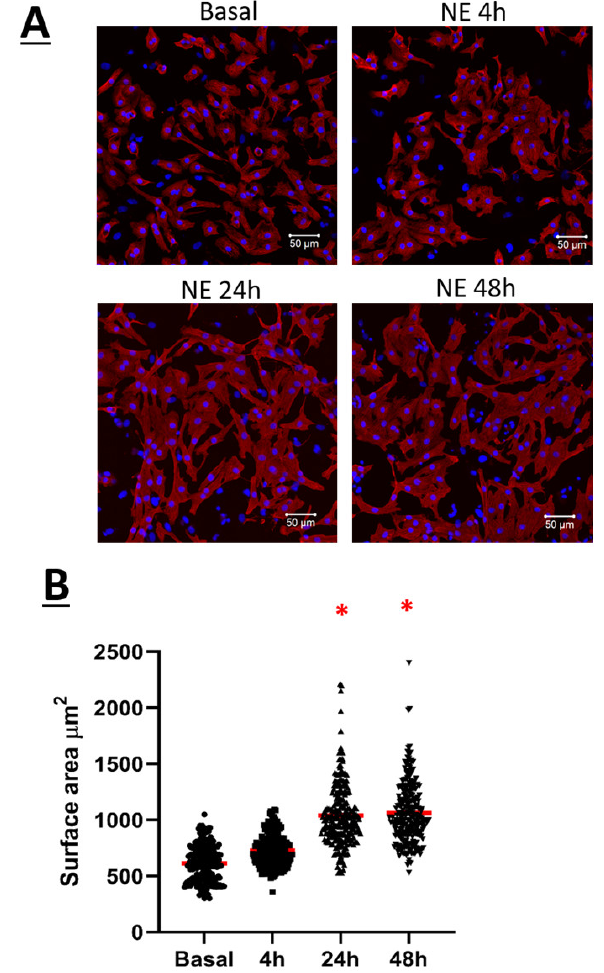
Figure 1. ( A ) Neonatal rat ventricular cardiomyocytes (NRVMs) in basal condition, treated μM norepinephrine (NE) for 4 h, 24 h or 48 h. Cardiomyocytes were fixed with 2% PAF for 20 min